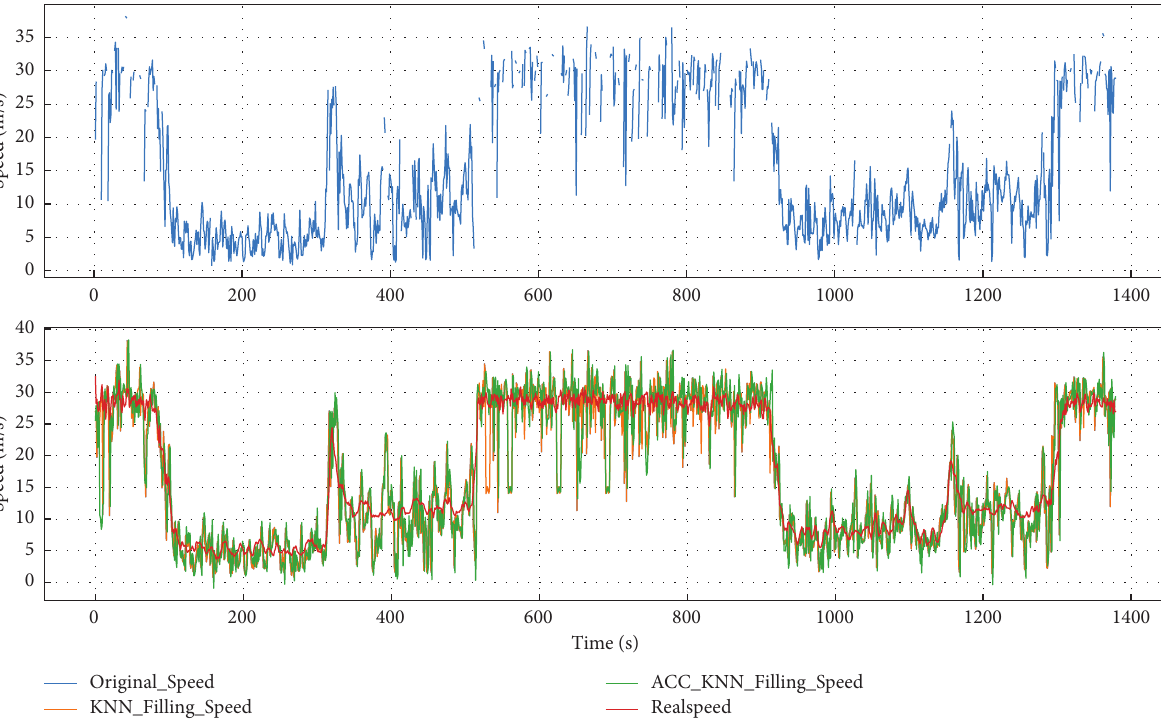
Figure 4: Speed before and after filling using different models. Note: KNN_Filling_speed � speed filled by K-Nearest Neighbors; and ACC_KNN_Filling_speed � speed filled by K-Nearest Neighbors combined with